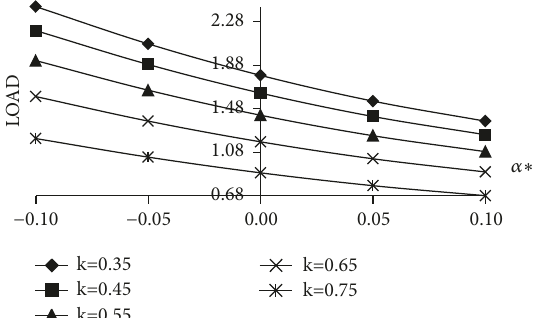
Figure 15: Distribution of load bearing capacity with respect to 𝛼 ∗